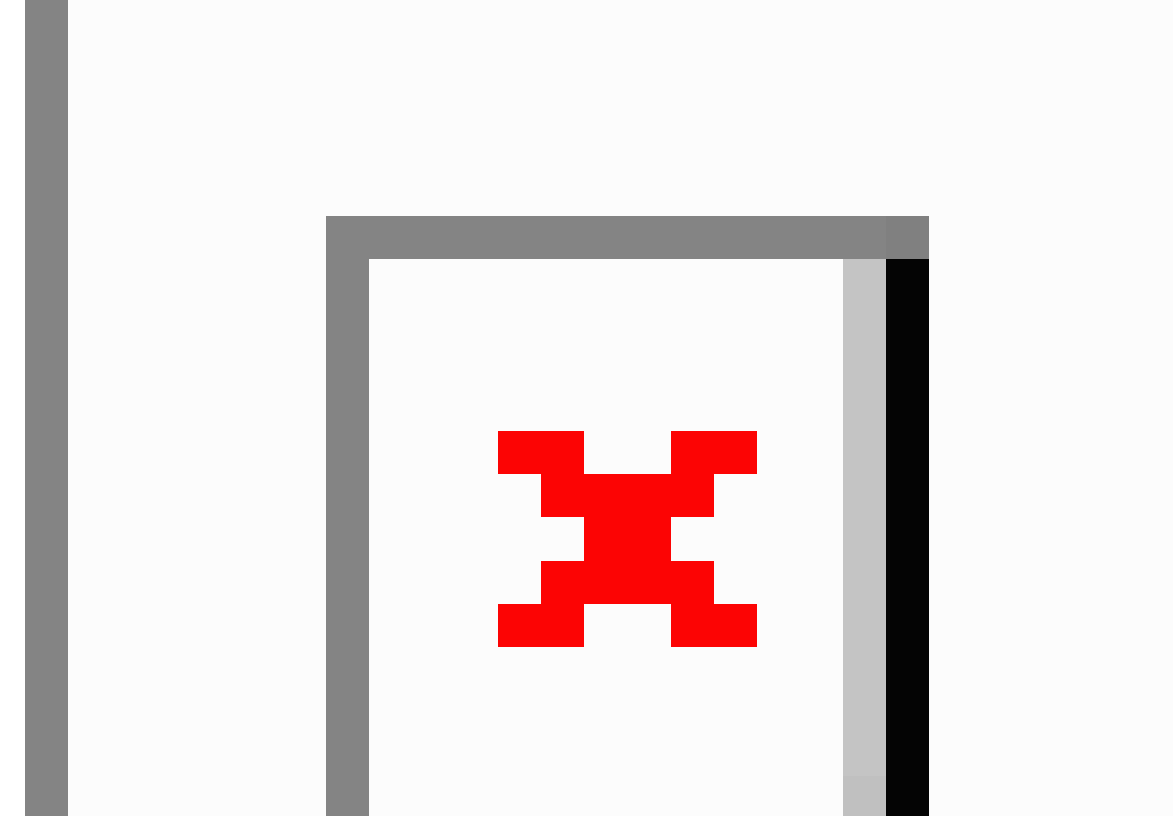
Figure 1. Method development process used in developing our wiki tool: (1) establish content and format options to include in the system, (2) build a Web-based application to enable representation of each content and format permutation through iterative revisions by the research team, while concurrently recruiting participants for the next stage, (3) test the tool in each stakeholder group to optimize content and format choices and system usability, (4) revise the tool based on data from the testing